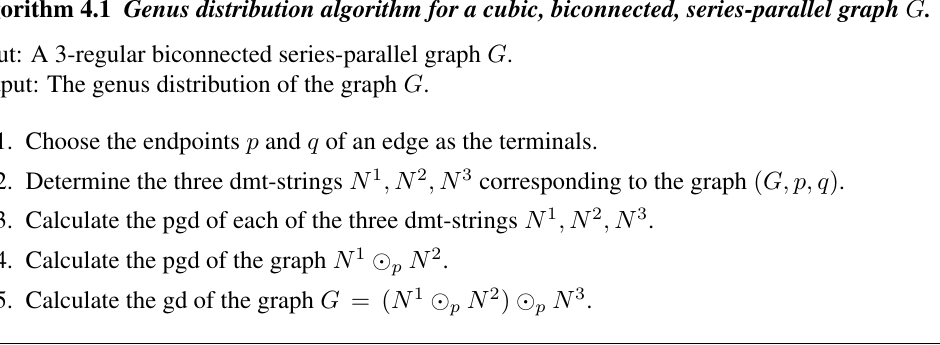
Fig. 3: The modified parallel operation (cid:12) p .